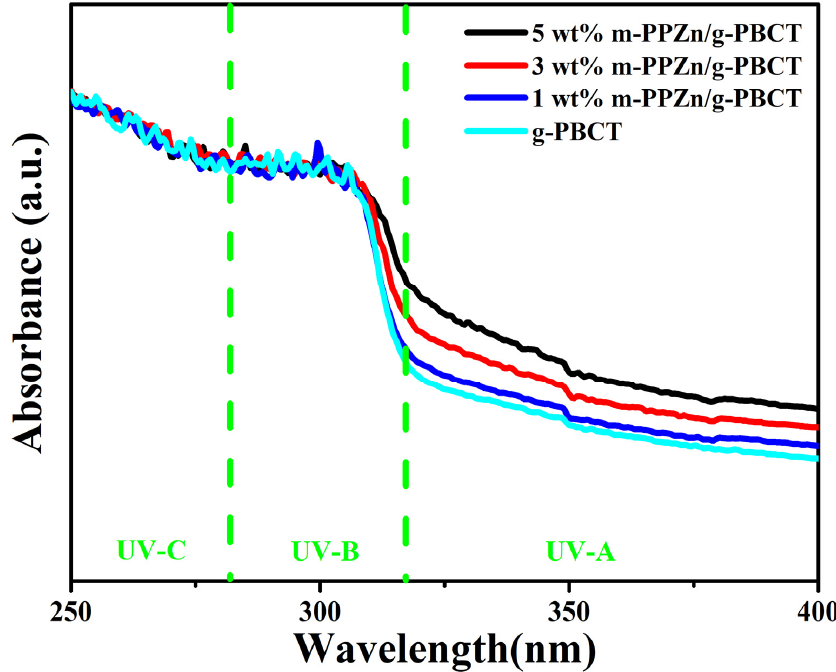
Figure 5. UV-Vis spectra of the g-PBCT and various weight ratios of g-PBCT/m-PPZn composites. The green lines in this figure illustrate the UV-A, UV-B, and UV-C regions.